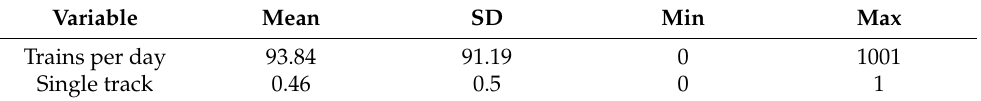
Table 1. Descriptive statistics of the variables in the train traffic data with N = 10,040,607 observations.